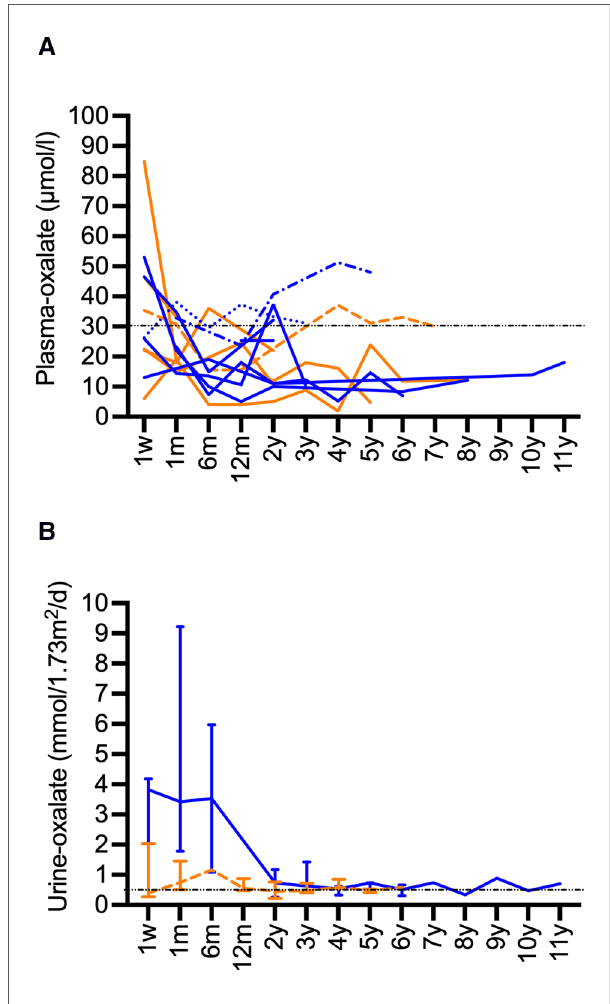
FIGURE 3 Long-term data for oxalate after CLKT. ( A ): Plasma-oxalate after CLKT (infantile PH1: blue, juvenile PH1: orange), patient 1 ( ———— ) and patient 3 (········): oxalate values after 1. CLKT transplantation are shown, patient 2 (-·-·-): data after second CLKT are shown, patient 13 (fatal case) is not shown, data for week 1 after transplantation might be compromised by KRT; ( B ): Urine-oxalate values (median and range, infantile PH1: blue, juvenile PH1: orange) in patients (infantile type n